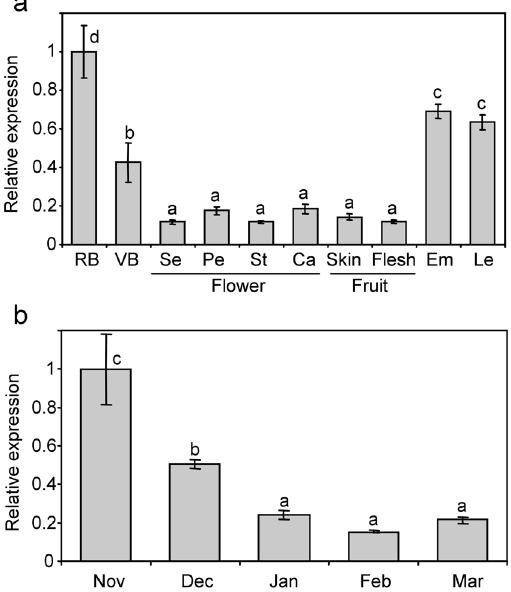
Figure 1. Relative expression of PsSAP1 in peach by qRT-PCR. In ( a ), different plant tissues were tested, including reproductive bud (RB), vegetative bud (VB), sepal (Se), petal (Pe), stamen (St), carpel (Ca), fruit skin, fruit flesh, embryo (Em) and leaf (Le). In ( b ), reproductive buds were collected at different developmental stages, from November to March. In March samples bud dormancy was already released. An expression value of one is assigned to the first sample. Data are means from two biological samples with three technical replicates each, with error bars representing standard deviation. Different letters ( a – d ) indicate significant difference between samples with a confidence level of